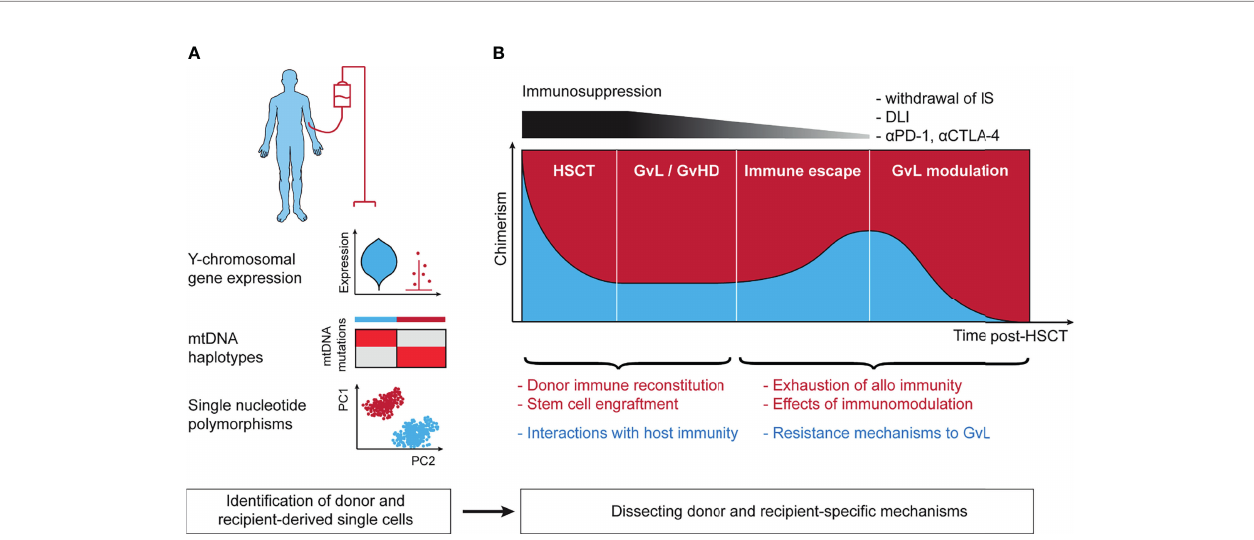
FIGURE 2 | Lineage-tracing in the context of allogeneic hematopoietic stem cell transplantation. (A) Technical approaches to annotation of donor- and recipient- derived cells. Y chromosomal gene expression is able to robustly separate donor and recipient in the context of sex-mismatched transplantation. mtDNA haplotypes leverage germline single nucleotide polymorphisms in the mitochondrial genome and can distinguish between matched-unrelated donor and recipient. Single nucleotide polymorphisms distinguish between all donor and recipient pairs except for identical twins. (B) The post-transplant setting harbors context-speci fi c questions in the 4 stages following stem cell infusion. These include (1) the mechanisms of initial stem cell engraftment, (2) the interaction of host and recipient as basis for GvL and GvHD, (3) immune escape leading to disease relapse, and (4) reinvigoration of GvL following effective immunotherapeutic intervention. mtDNA, mitochondrial DNA; IS, immunosuppression; DLI, donor-lymphocyte infusion; a PD-1, antibody against programmed cell death protein 1 (PD-1); a CTLA-4, antibody against cytotoxic T-lymphocyte-associated protein 4; HSCT, hematopoietic stem cell transplantation; GvL, graft-versus-leukemia; GvHD, graft-versus-host disease; PC1/2, principal component